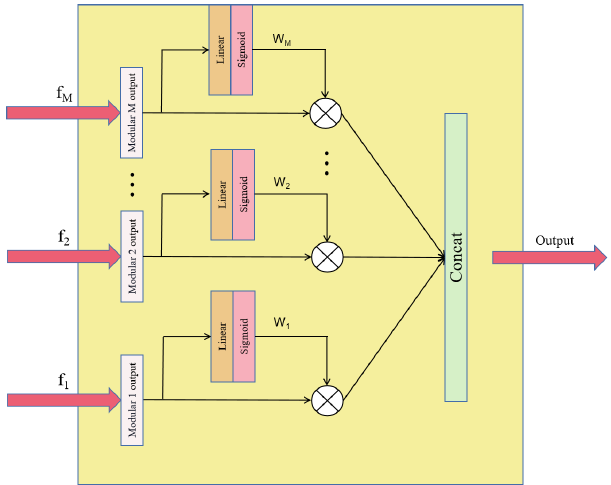
Figure 4. Feature Weighted Fusion Based on Attention